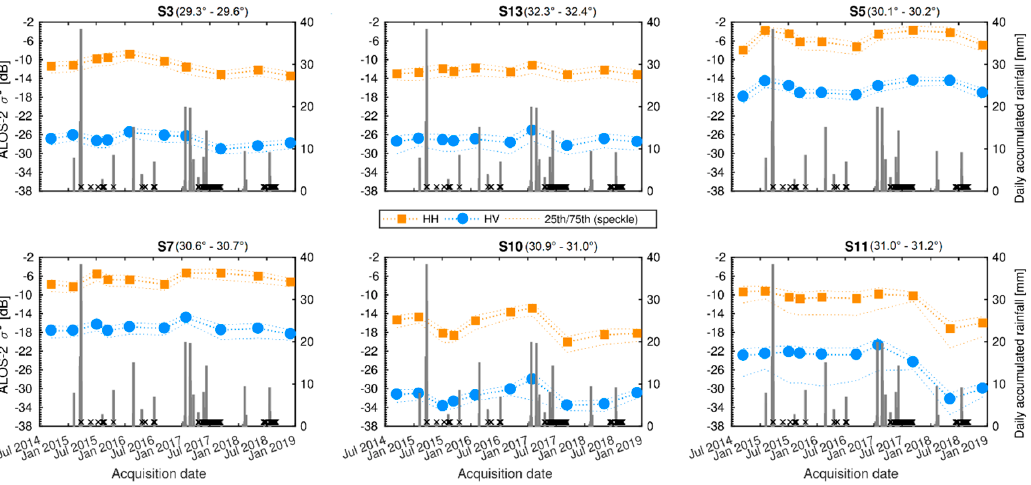
Figure 13. The same as Figure 12 for sites corresponding to Hard crust 1. Ascending orbit. The local incidence angles are indicated in degrees. Daily accumulate rainfalls recorded at Socaire are in grey bars, and snowfall cover also shown as black crosses.